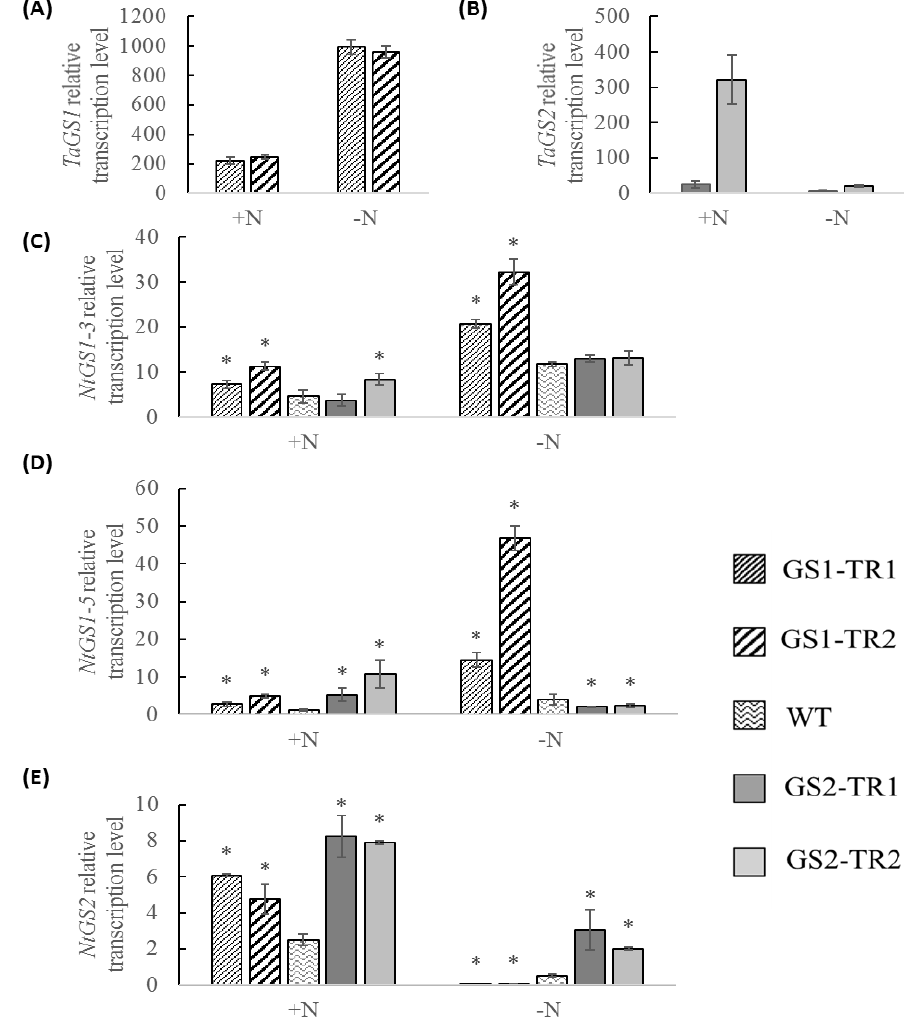
Figure 2. Relative transcription levels of TaGS1 ( A ), TaGS2 ( B ), NtGS1-3 ( C ), NtGS1-5 ( D ) and NtGS2 ( E ) in the root of transgenic plants grown under nitrogen-sufficient (N+) and nitrogen-starvation (N − ) conditions. Data are means of three independent biological replicates ± SD. Asterisks indicate that the data is significantly different ( p < 0.05) from the data of WT plants.